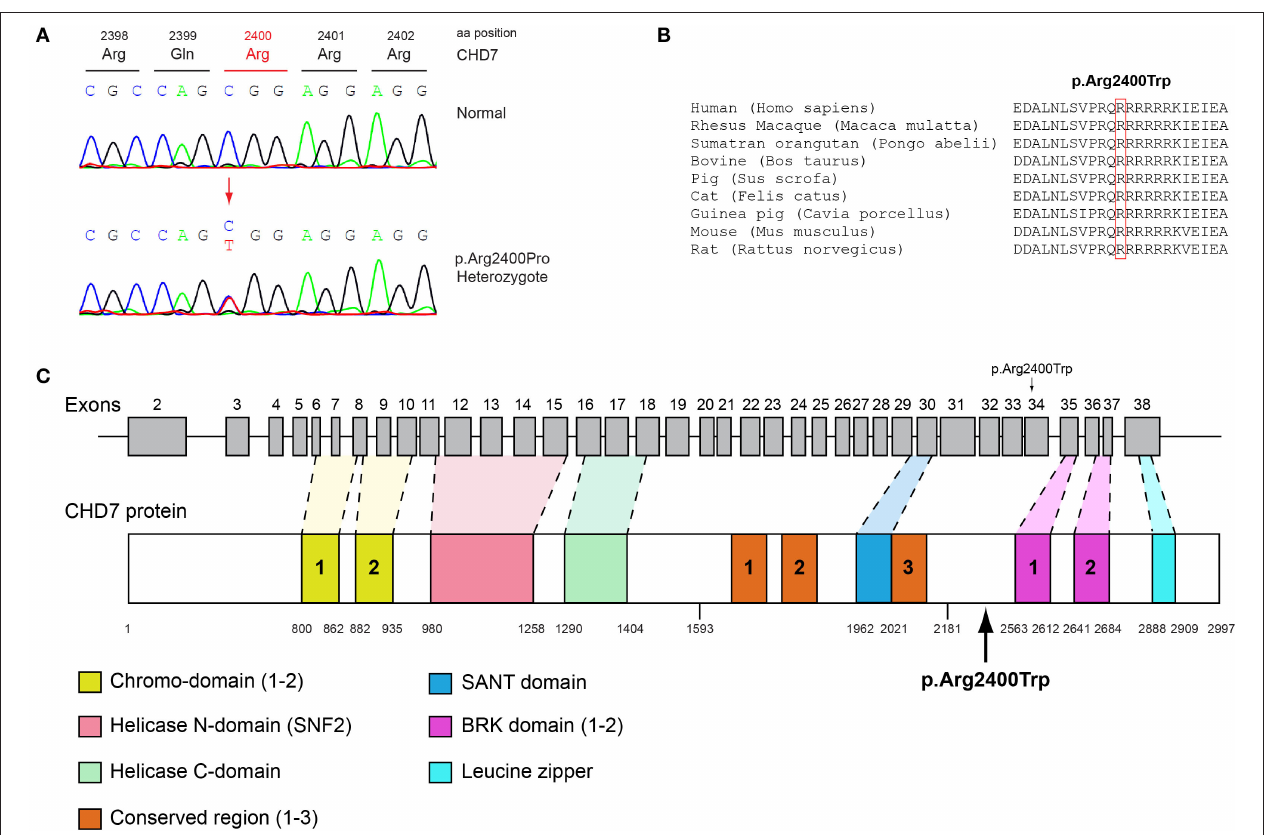
FIGURE 4 | Identification of the p.Arg2400Trp CHD7 variant. (A) Sequence electropherogram of a male patient identified with the novel CHD7 p.Arg2400Trp variant. (B) Multiple sequence alignment of the amino acid at position 2,400 of the CHD7 protein from various species. The conserved arginine amino acid at position 2,400 is indicated by red color. (C) Schematic representation of the CHD7 gene and protein of a male patient identified with the novel p.Arg2400Trp